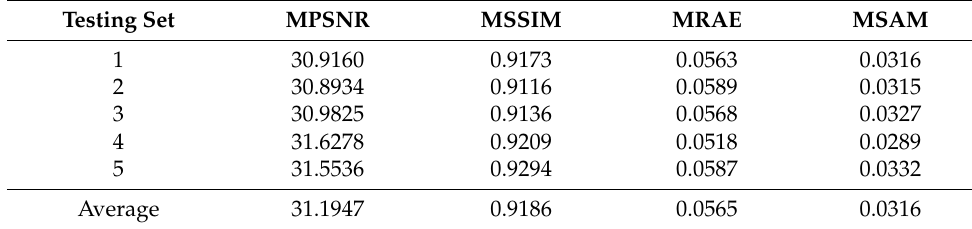
Table 6. Cross-validation of